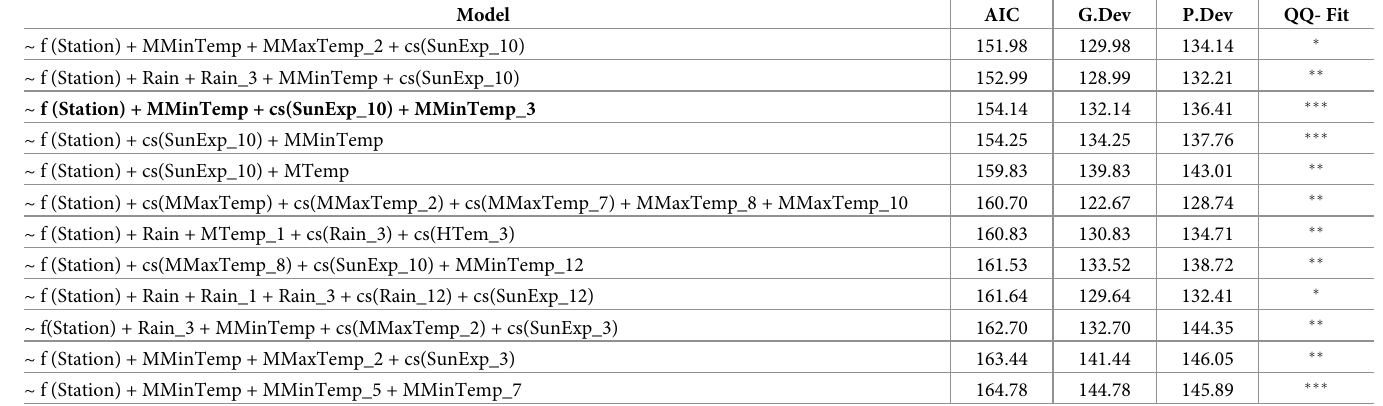
Table 2. Binomial models explaining the occurrence of Jacaranda flowering in Melbourne, Perth, Sydney, Parramatta, and Penrith between 2009–2019. The num- ber of asterisks indicate model fit ( � Low fit, �� Moderate fit, ��� Good fit). Bold letters outline the best models with the best fit, the least number of covariates, and the lowest Akaike International Criterion (AIC), Global and Partial deviance (G.Dev and P.Dev). The explanatory variables include Mean Minimum Temperature (MMinTemp), Mean Maximum Temperature (MMaxTemp), Mean Temperature (MTemp), Highest Temperature (HTemp), Rainfall (Rain) and Sun Exposure (SunExp) recorded per month at each weather station. Station is a factor (f) and some variables are smoothed (cs). The number after the variable indicates the lag in months when an association to Jacaranda flowering was